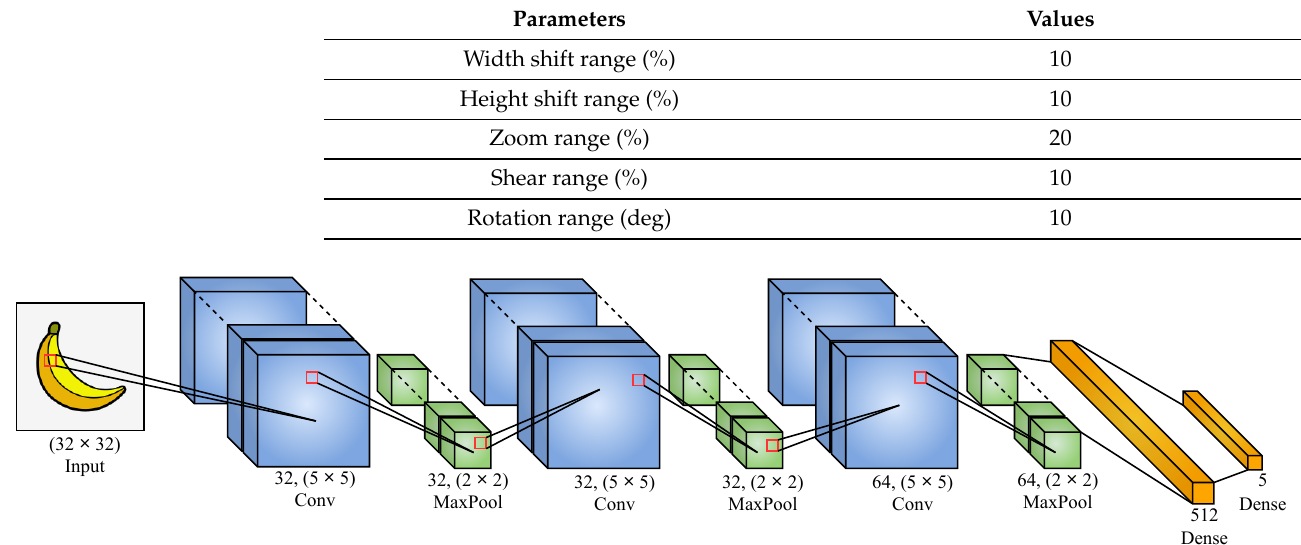
Figure 2. Architecture of the proposed